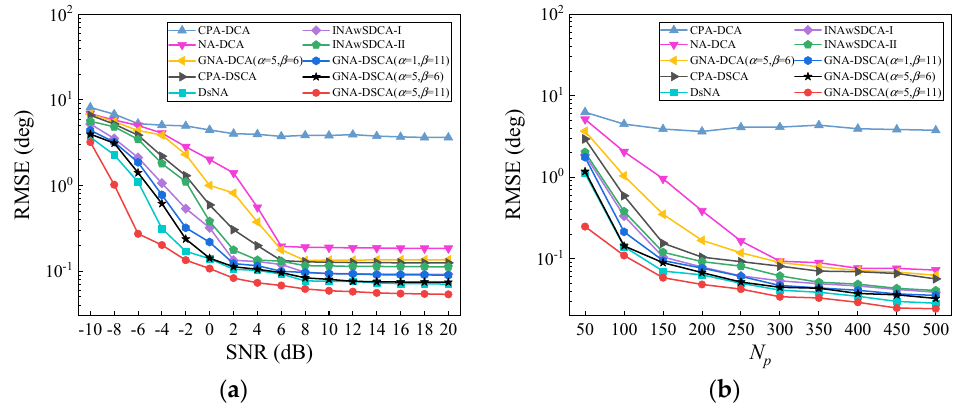
Figure 5. Comparison of RMSE, where K = 21. ( a ) RMSE versus SNR with N p = 100; ( b ) RMSE versus the number of pseudo-sampling snapshots with SNR = 0 dB.